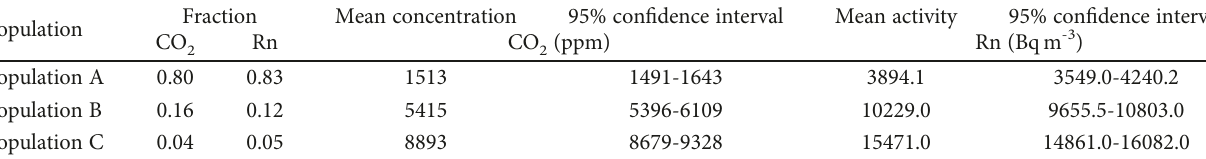
Table 3: Statistical parameters of partitioned CO